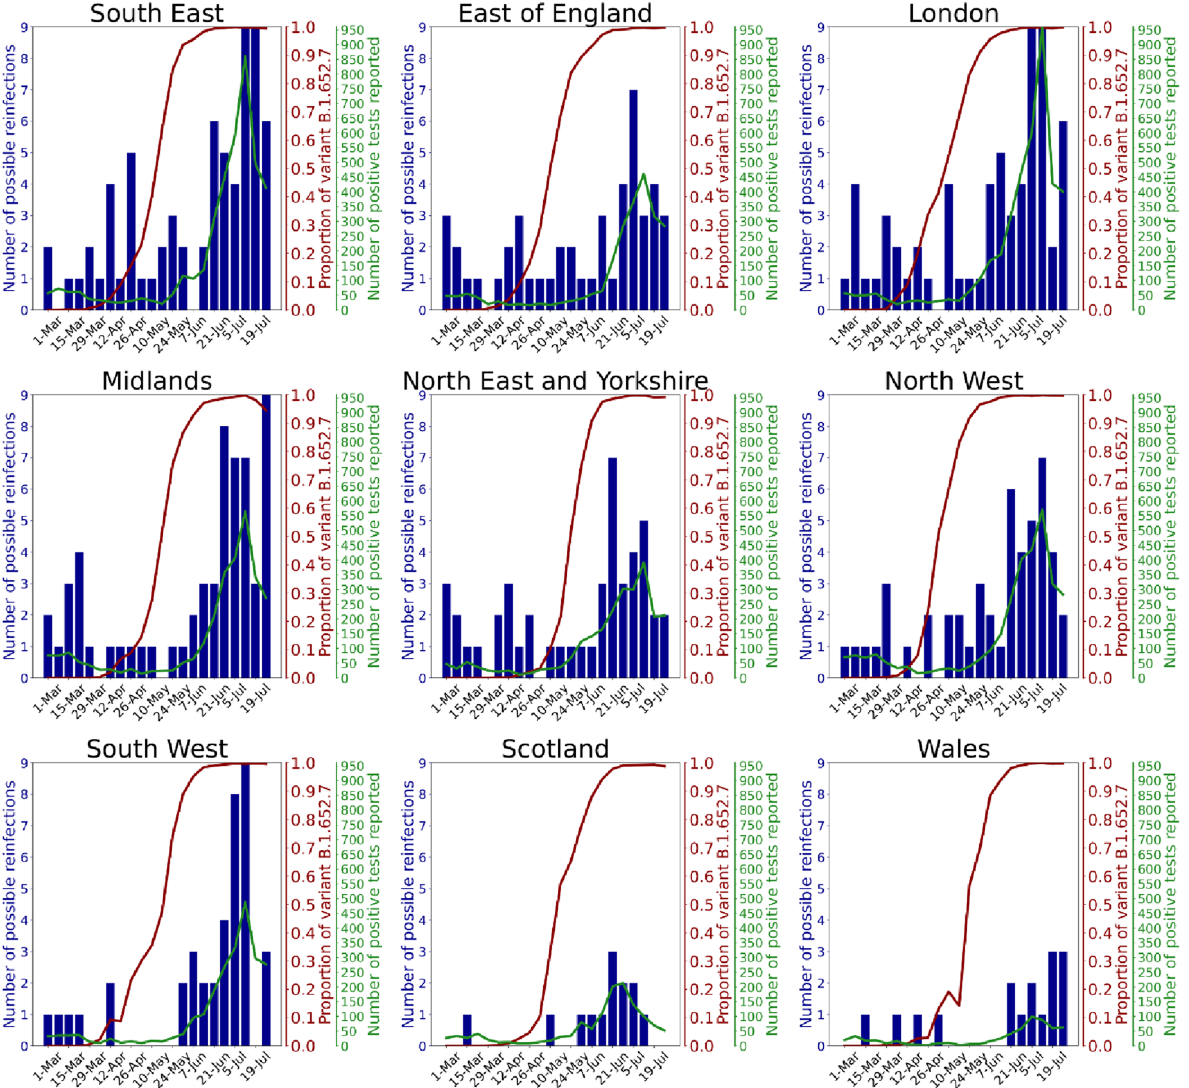
Figure 5. Regional graphs presenting evolution of numbers of reported natural reinfection with SARS-CoV-2. Reported natural reinfection is charted over time in weeks (starting from March 1, 2021) (x-axis). The blue bars graph the absolute number of cases with re-infection. The red line graphs the proportion of the Delta variant among circulating SARS-CoV-2 (COG UK—Supplementary Table S1). The green line graphs the total numbers of positive tests reported by ZOE COVID Symptom Study app users. Data are combined for East and West Midlands, and for Yorkshire and the North